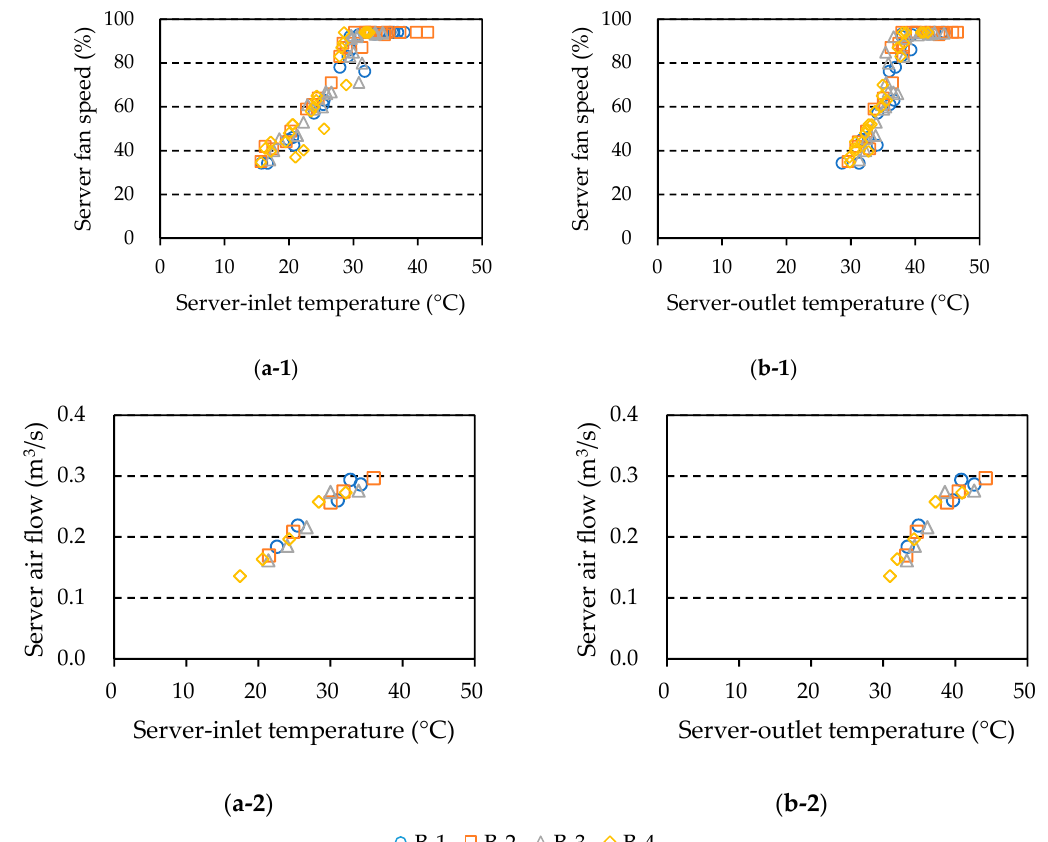
Figure 5. Relationships of server-fan speed and server airflow (experiment A) with ( a ) server-inlet temperature and ( b ) server-outlet temperature for each CPU usage rate at server ambient temperature.